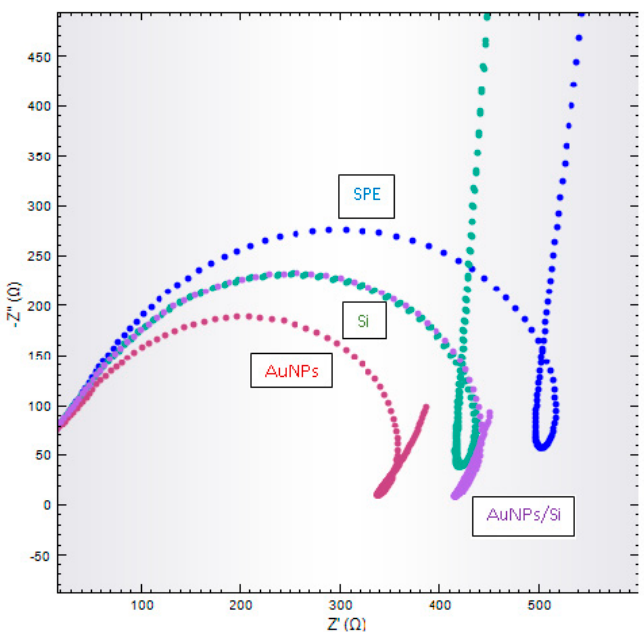
Figure 3. Nyquist plot for screen-printed electrodes (SPEs) (blue line), AuNPs/SPE (red line), Si/SPE (green line), and AuNPs/Si/SPE (purple line) in 0.05 M Na-phosphate buffer solution containing 0.1 M NaCl at pH7.